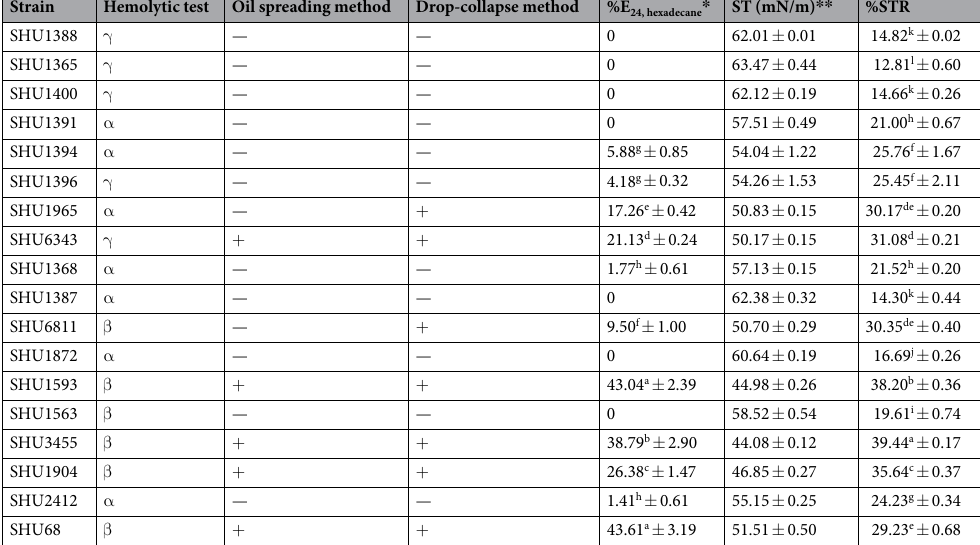
Table 2. Results of qualitative and quantitative screening assays for BS production. Values are representatives of mean ± S.D. (n = 3). Values followed by different superscripts in a column are significantly different (P <